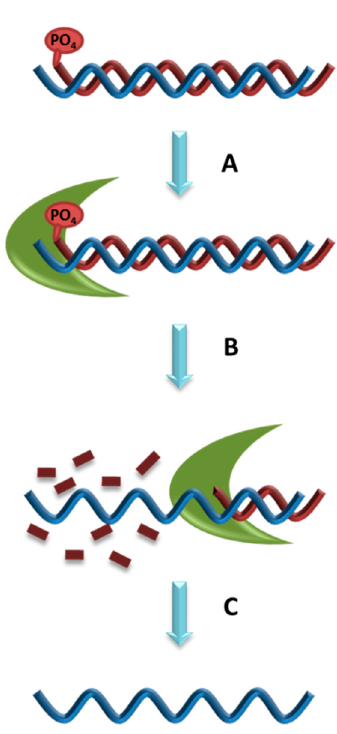
Figure 3. Generation of ssDNA with lambda exonuclease. A . Adding enzyme to dsDNA which has a phosphate group; B . Incubate enzyme with dsDNA; C . Extract and purify the ssDNA.